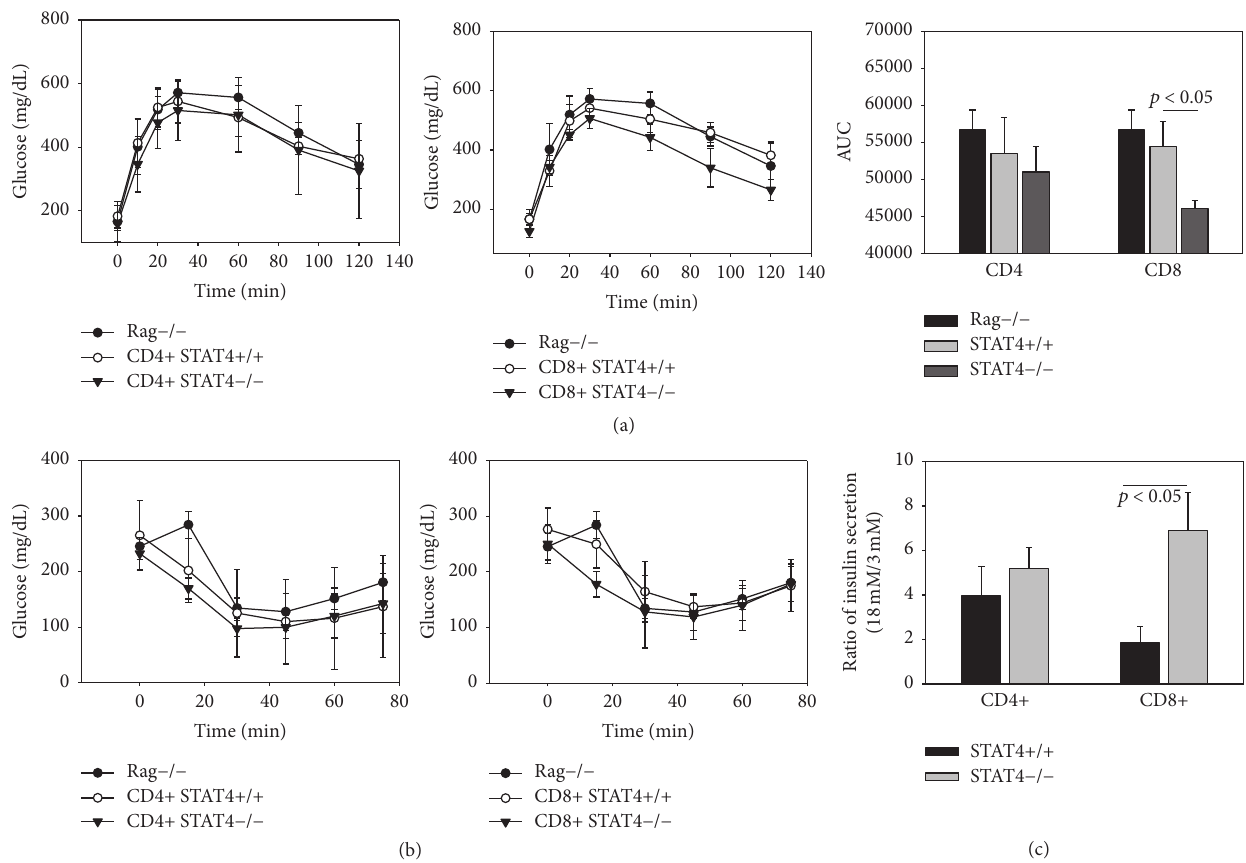
Figure 4: Glucose tolerance, insulin resistance, and islet insulin secretion. Rag1 − / − controls and Rag1 − / − mice adoptively transferred with eitherSTAT4 − / − CD4+orCD8+orwithSTAT4+/+CD4+orCD8+cellswerefedahighfatdietfor15weeks.Intraperitonealglucosetolerance test (GTT) (a) and insulin tolerance test (ITT) (b) were performed and area under curve (AUC) was measured for the GTT. Plotted values in the histogram are average ± SEM from 𝑛 = 6 –12 mice/group. Statistical analysis was performed using one-way ANOVA. (c) In vitro glucose stimulated insulin secretion was measured in pancreatic islets in mice after 15 weeks on HFD. Islets were cultured overnight and subsequently treated for 1hr with 3 mM or 18mM glucose. Insulin was measured by ELISA in the media of the islets stimulated with low or high glucose concentration. Results represent average ± SEM from 𝑛 = 5 mice/group; the null hypothesis was rejected for a 𝑝 value <